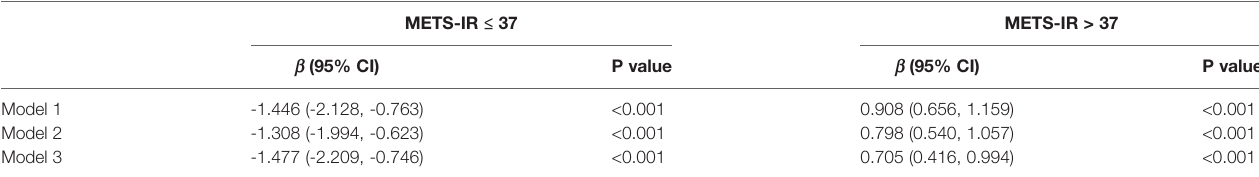
TABLE 4 | Multivariable linear regression between METS-IR and CIIS.